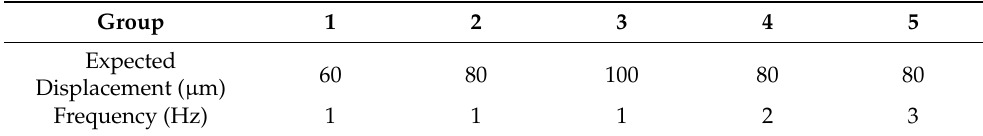
Table 6. Parameters of hysteresis compound compensation.